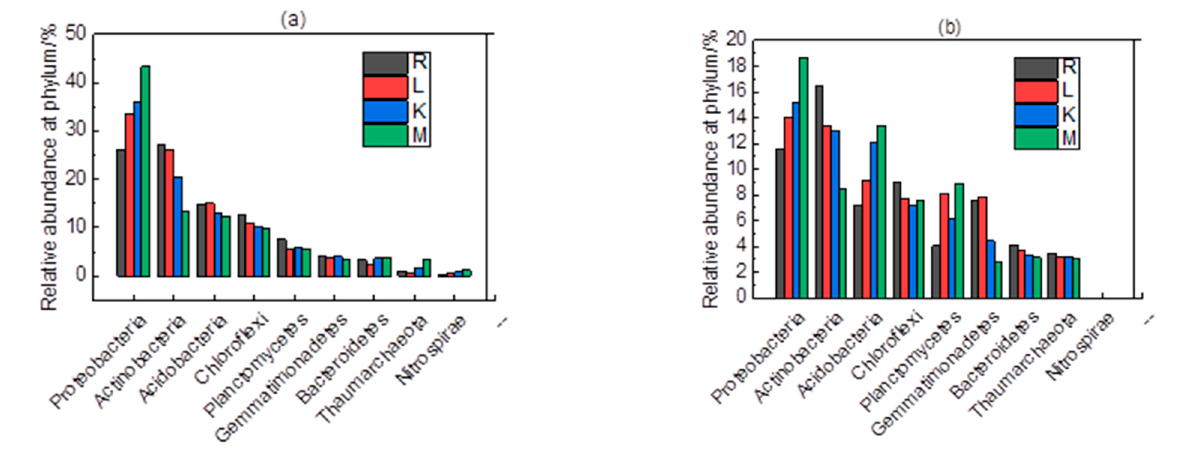
Figure 3. Soil bacterial relative abundance ( a , b ) in reclaimed soils with different vegetation types. ( a ) phylum. ( b ) class.